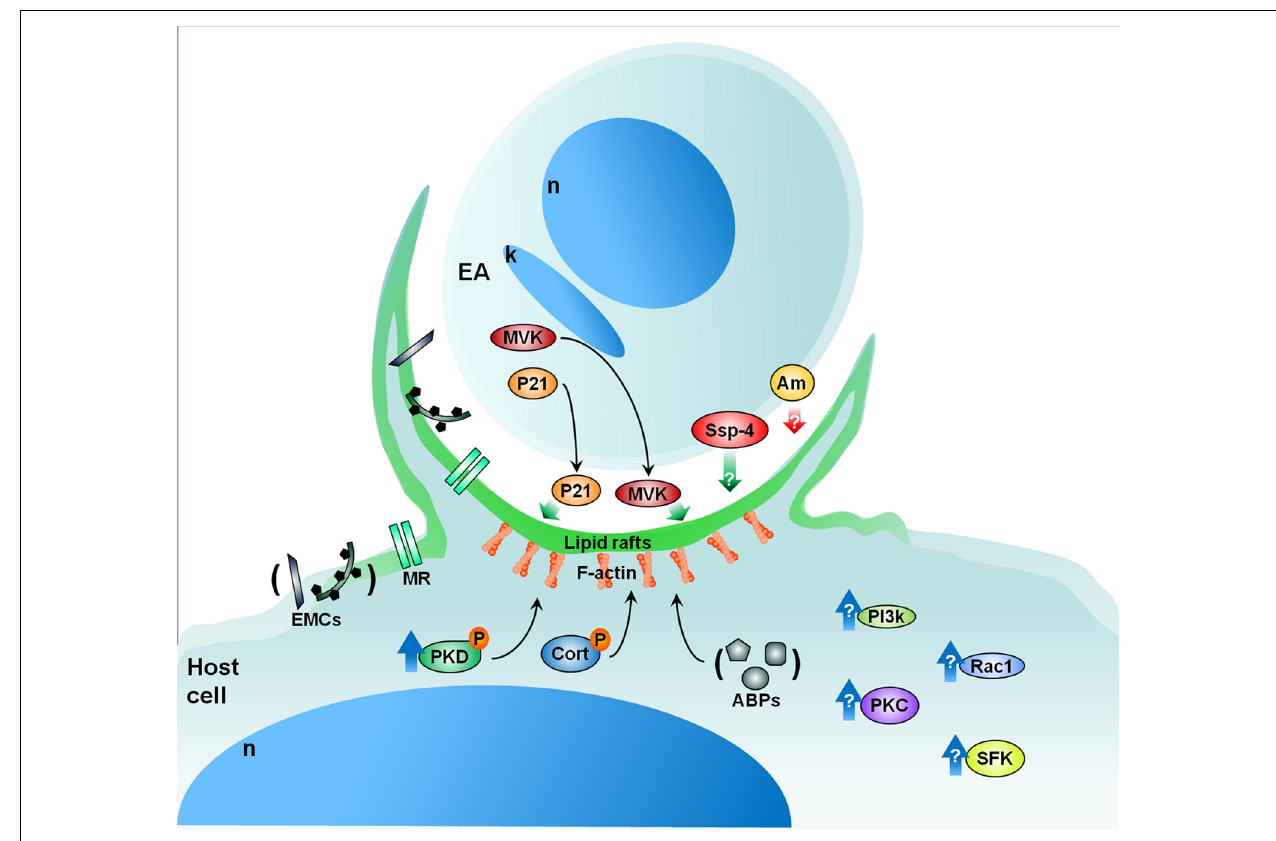
FIGURE 3 | Proposed model for EA signaling. EAs secrete factors such as P21 and MVK that aid in EA uptake by cells in culture. EAs also present specific glycoproteins (i.e., Ssp-4) important for attachment and penetration while other EA glycoproteins (i.e., amastins-Am) may negatively modulate amastigote invasion. From the cellular perspective, lipid rafts are essential to parasite internalization in both macrophages and epithelial cells. Furthermore, the mannose receptor of certain cells may recognize mannose residues expressed by EAs which also participate in EA uptake. Upon contact, EAs recruit PKD, actin (F-actin), and other actin-binding proteins (ABPs) such as